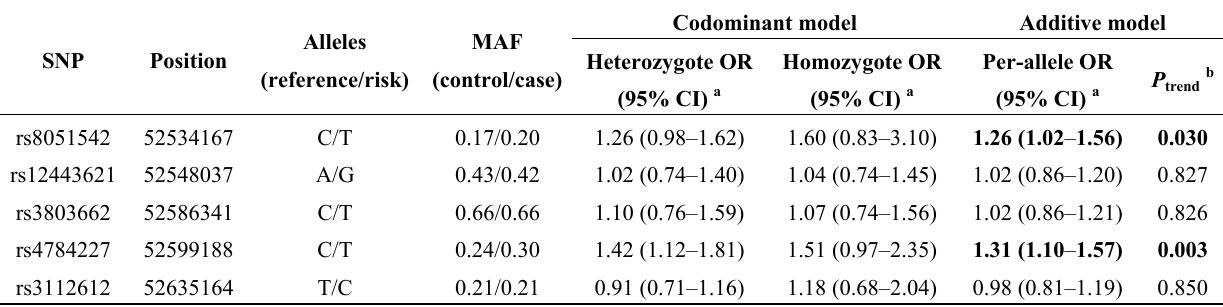
Table 2. Association of breast cancer risk with five single nucleotide polymorphisms (SNPs) in TOX3/LOC643714 in Chinese